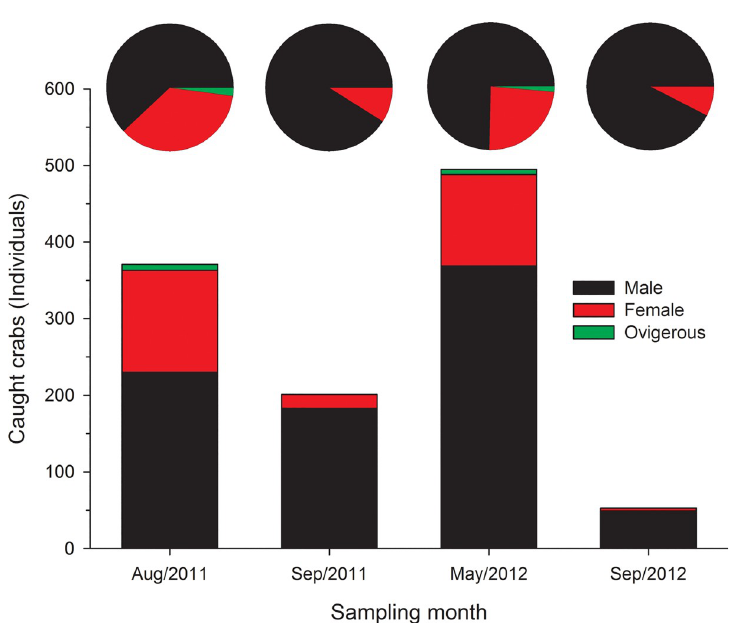
Fig 4. Number of crabs Xenograpsus testudinatus and proportion of male, female and ovigerous collected from different sampling months.